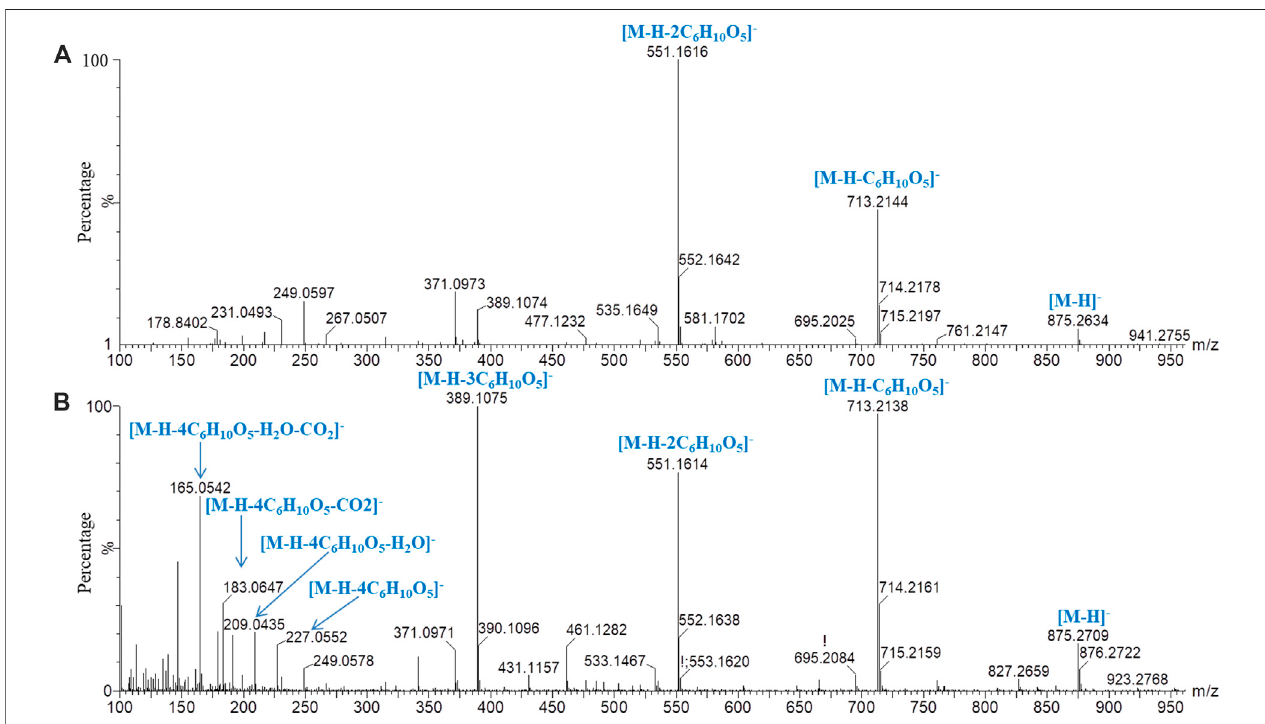
FIGURE 6 | Mass spectrograms and major cleavage pathways of peak 47 ( m/z 875.2664) in negative ion mode. (A) Low-energy mass spectrometry; (B) high- energy mass spectrometry.